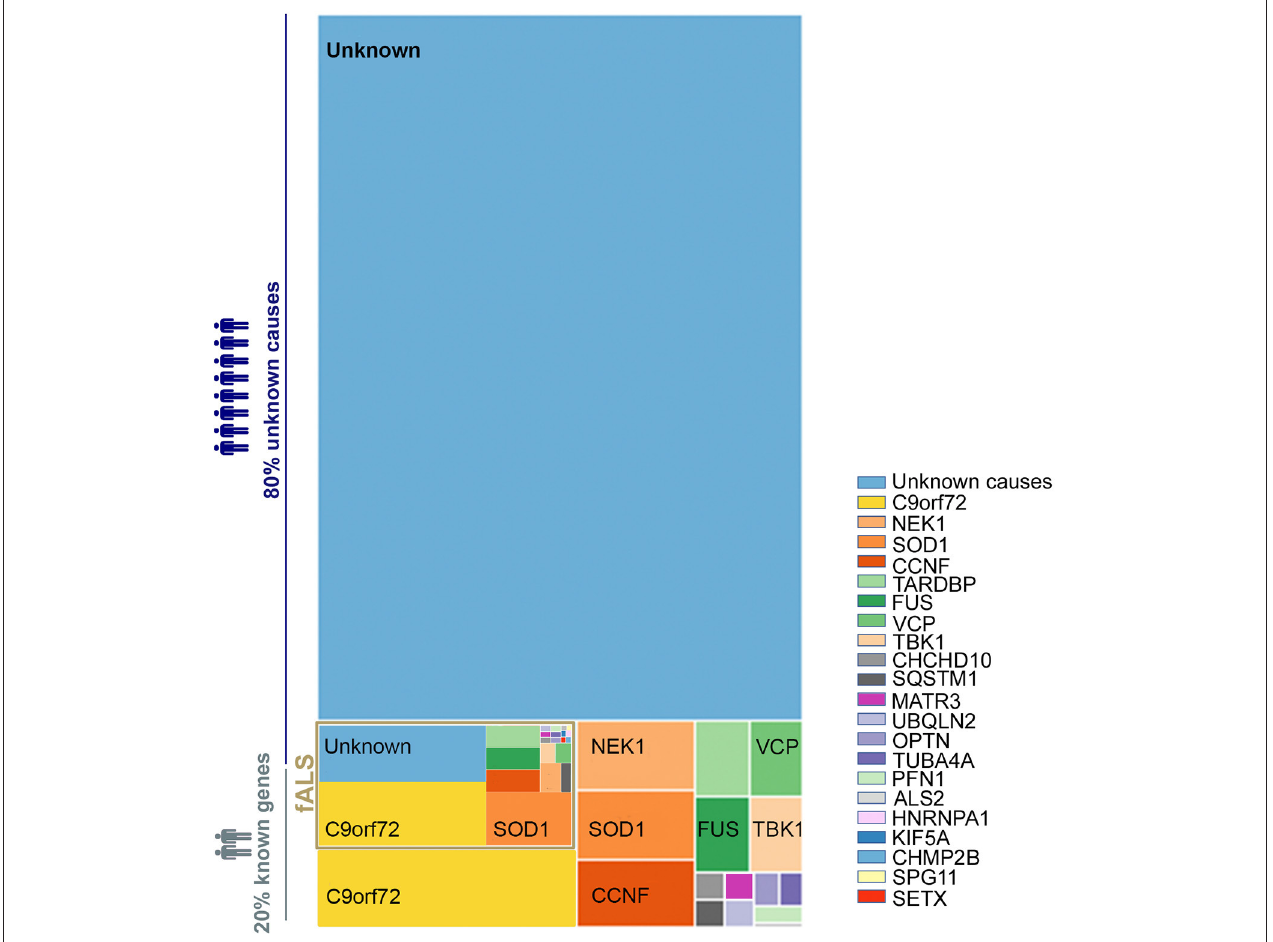
FIGURE 1 | Distribution of genetic basis among the ALS population. A treemap representation of the proportion of ALS patients carrying known causative mutation. The full rectangle represents 100% of all ALS cases. The fALS are highlighted in gold with a frequency adjusted to represent 7.5% of the total (as fALS is estimated at 5–10% of all ALS cases). The two light blue blocks represent those with no known ALS-associated gene mutation among sporadic and familial cases. Cases with known mutations are represented in the other blocks, broken down by affected gene. The color code for each gene is preserved between familial and sporadic cases. The size of each block is proportional to the percentage of ALS associated to the considered genes–proportions given in Volk et al. (13). Overall, some 80% of ALS cases (sALS and fALS combined) are not explained by a known mutation.